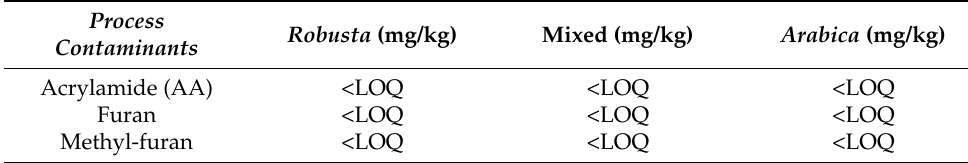
Table 3. Concentrations (mg/kg) of process contaminants in three classes of samples ( n = 10) of coffee silverskin (CS).